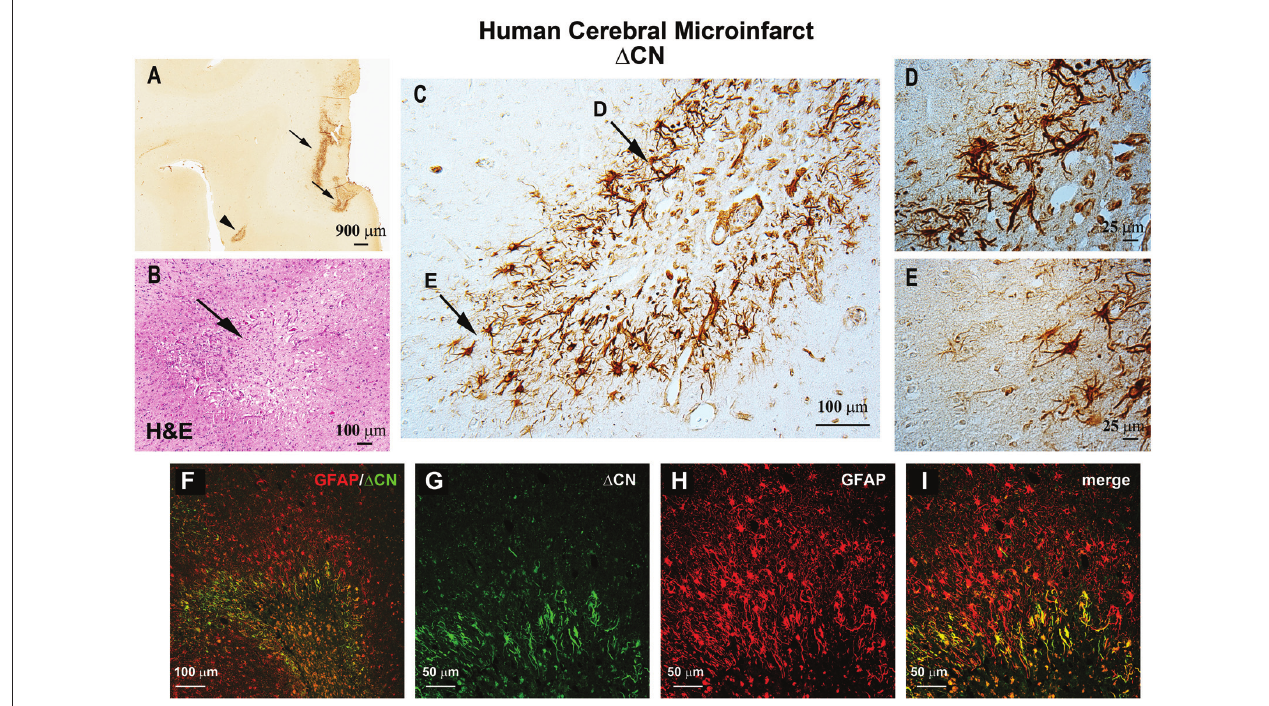
FIGURE 1 | ∆ CN is intensely expressed in activated astrocytes surrounding microinfarcts in human neocortex. (A) Representative low magnification photomicrograph from superior and middle temporal gyrus (SMTG) of a 90 year old human subject with multiple microinfarcts, but little-to-no Alzheimer’s pathology (Braak stage II) ∆ CN labeling is present around several microinfarcts (arrows and arrowhead). (B) Serial section through STMG stained by H&E to confirm the presence of microinfarcts. The image shown is a high magnification of the region denoted by the arrowhead in Panel (A) . (C) High power photomicrograph of the region in ( A ; arrowhead) showing intense ∆ CN antibody labeling of astrocytes. Higher magnification of the areas denoted by arrows are shown in panels (D,E) . (F) Merged confocal micrograph showing the colocalization of ∆ CN (green) with GFAP around a microinfarct in human SMTG (red). (G–I) High magnification images of the infarct in Panel (F) shown in individual channels (G,H) and merged (I) . Co-localization of ∆ CN with GFAP was most extensive in the region immediately adjacent to the infarct. From Pleiss et al. (2016) used with permission.